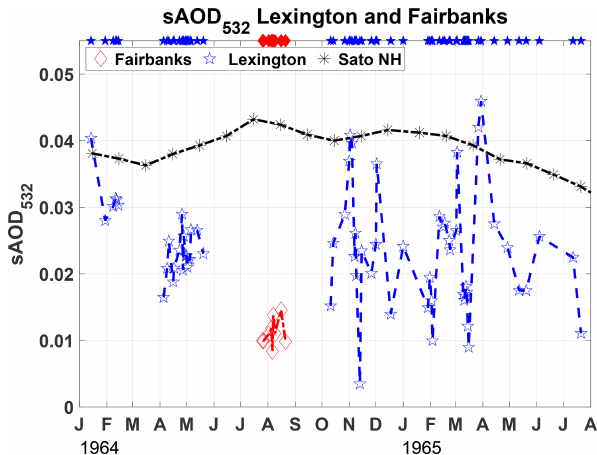
Figure 4. Stratospheric aerosol optical depth (sAOD 532 ) for Lex- ington (blue stars), Fairbanks (red diamonds), and for the Northern Hemisphere (black asterisks) for the period in which the measure- ments were conducted. The sAOD 532 values were calculated from the α a (532 ,z ) ∗ derived using local soundings. Blue stars and red diamonds on the top axis of the figure are the dates on which the measurements were conducted.